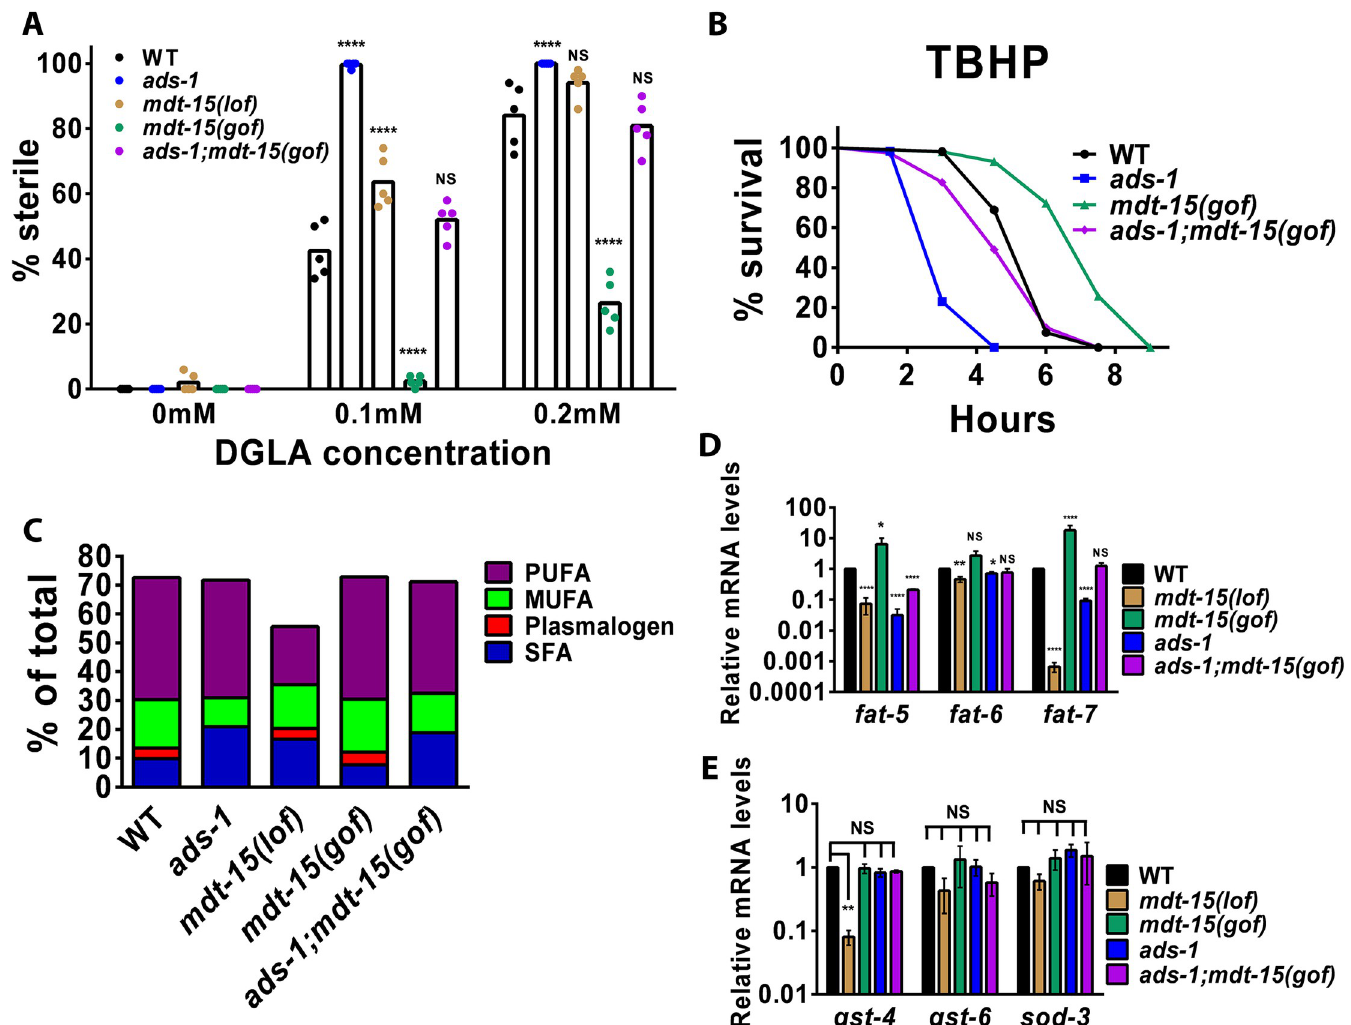
Fig 4. The mediator complex, MDT-15, plays a protective function through increased expression of Delta-9 desaturases in ether lipid deficiency. (A) Percentage (%) sterility in young adult worms of the indicated genotype raised on dihommo-gamma linolenic acid (DGLA). (B) Survival of young adult worms exposed to 14.7mM tert-butyl-hydroperoxide (TBHP). (C) Relative fatty acid composition determined with gas chromatography-mass spectrometry of strains used in (A) and (B). (D and E) Fold-change of basal mRNA levels in mutant worms relative to wild type worms grown on standard nematode growth media. mRNA levels were normalized to cdc-42 and Y45F10D.4. In (A) each dot represents an independent experiment of 50 worms for each treatment. Statistical significance was determined using a two-way ANOVA with Tukey’s test for multiple comparisons summarized in S2 Table. In (B) approximately 100–200 worms were used for each strain per treatment. Statistical significance for survival was determined using log rank tests (Mantel Cox) and is shown in S2 Table. In (C), values do not add up to 100% because dietary cyclopropane fatty acids and several others are not displayed in this chart. The complete fatty acid composition and sterility data are reported in S1 Table. In (D and E), student’s t-tests were performed to determine statistical significance and summarized in S2 Table. Statistical differences compared to WT are NS, not significant, � P < 0.05, �� P < 0.01, ��� P < 0.001, ���� P <